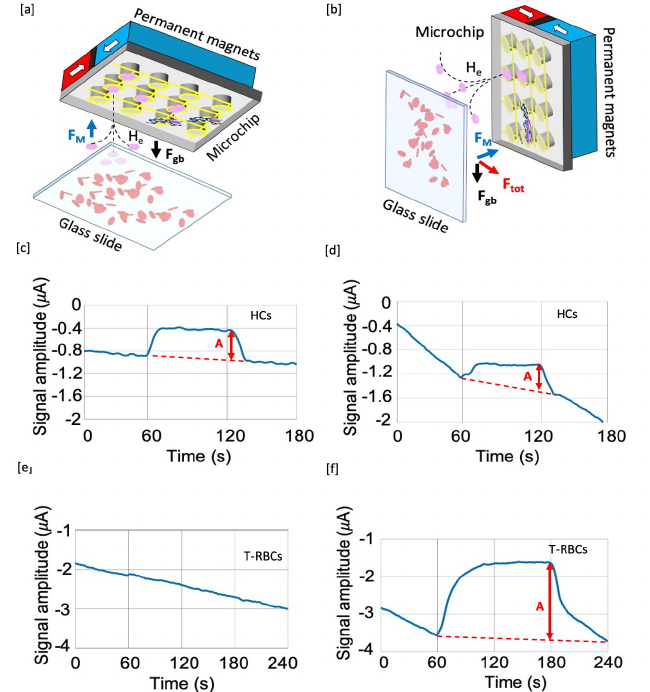
Figure 2. Detection system in horizontal ( a ) and vertical ( b ) configurations. In panels ( c , d ), the experimental measured current signal for hemozoin crystals samples is depicted, while in panels ( e , f ), the experimental curves are related to capture dynamics of bovine-treated red blood cells